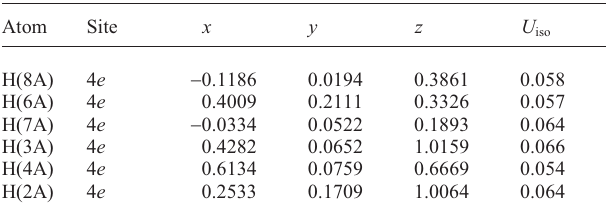
Table 2. Atomic coordinates and displacement parameters (in Å 2 )